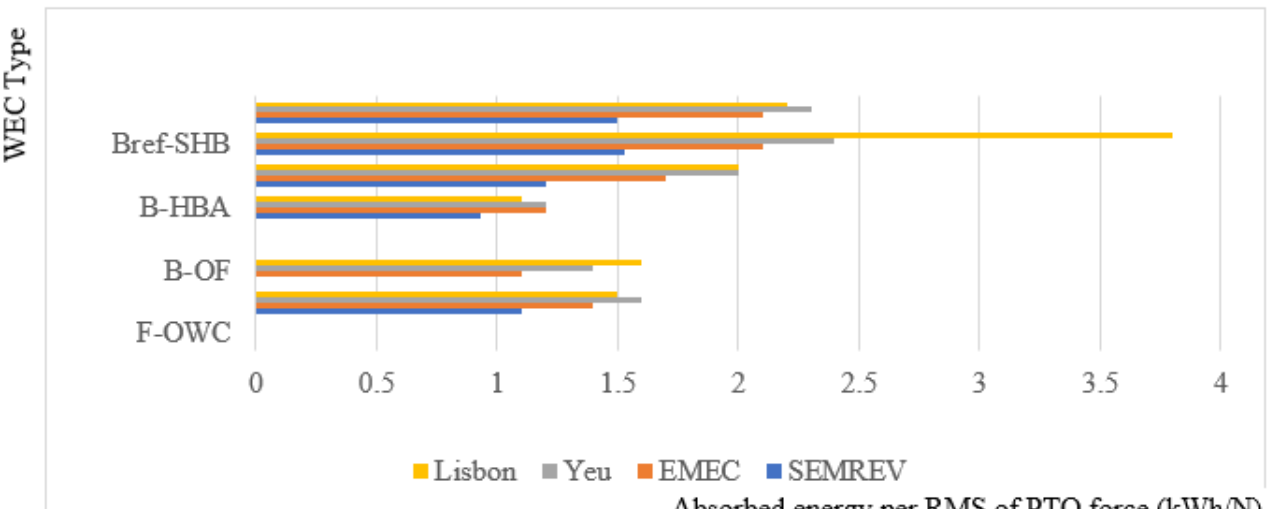
Figure 3. Performance comparison of the absorbed energy per surface area of WECs.